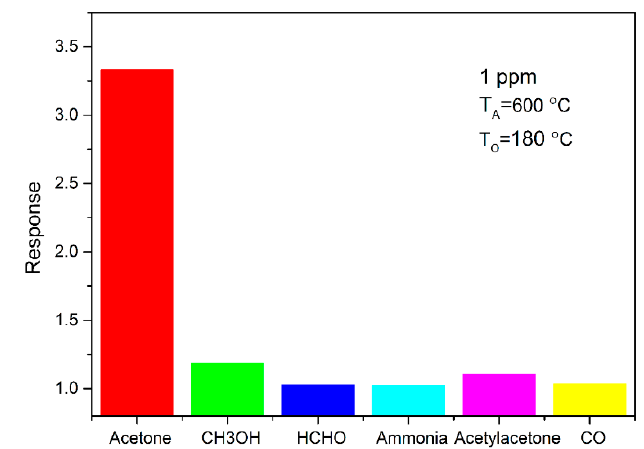
Figure 8. The response of SnO 2 thick film to different gases with a concentration of 1 ppm at 180 °C.